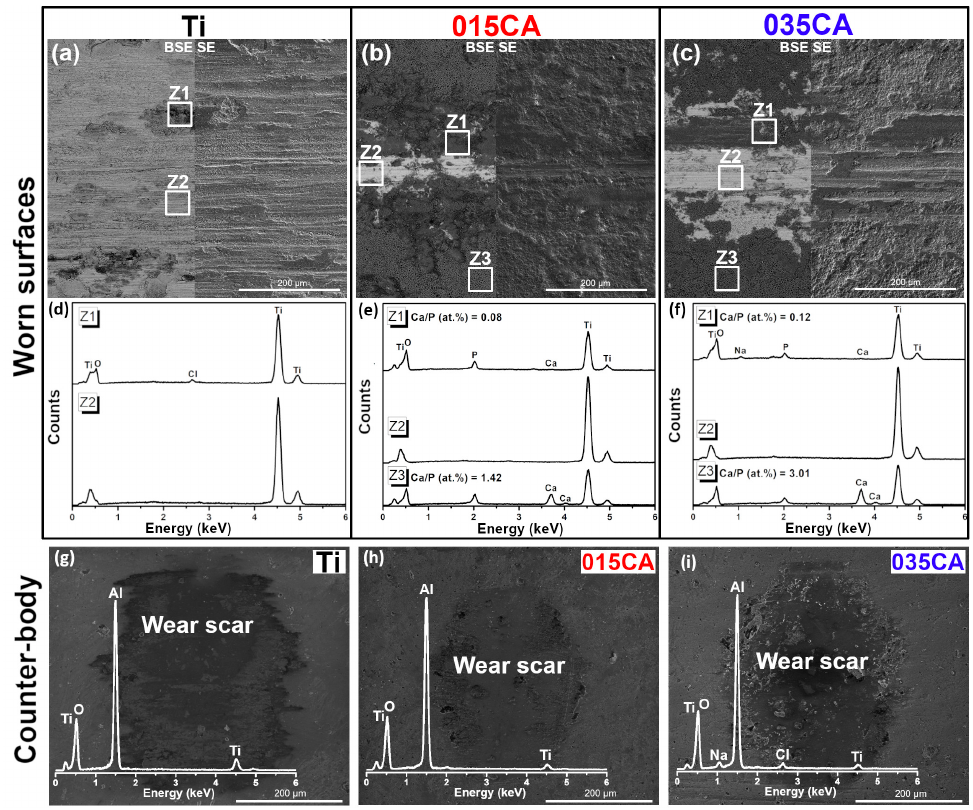
Figure 5. BSE/SE SEM images of the worn surfaces for ( a ) Ti, ( b ) 015CA, and ( c ) 035CA groups, EDS analysis of the worn surfaces for ( d ) Ti, ( e ) 015CA and ( f ) 035CA groups, and SE SEM images and EDS analysis of the counter-body surfaces for ( g ) Ti, ( h ) 015CA and ( i ) 035CA groups.